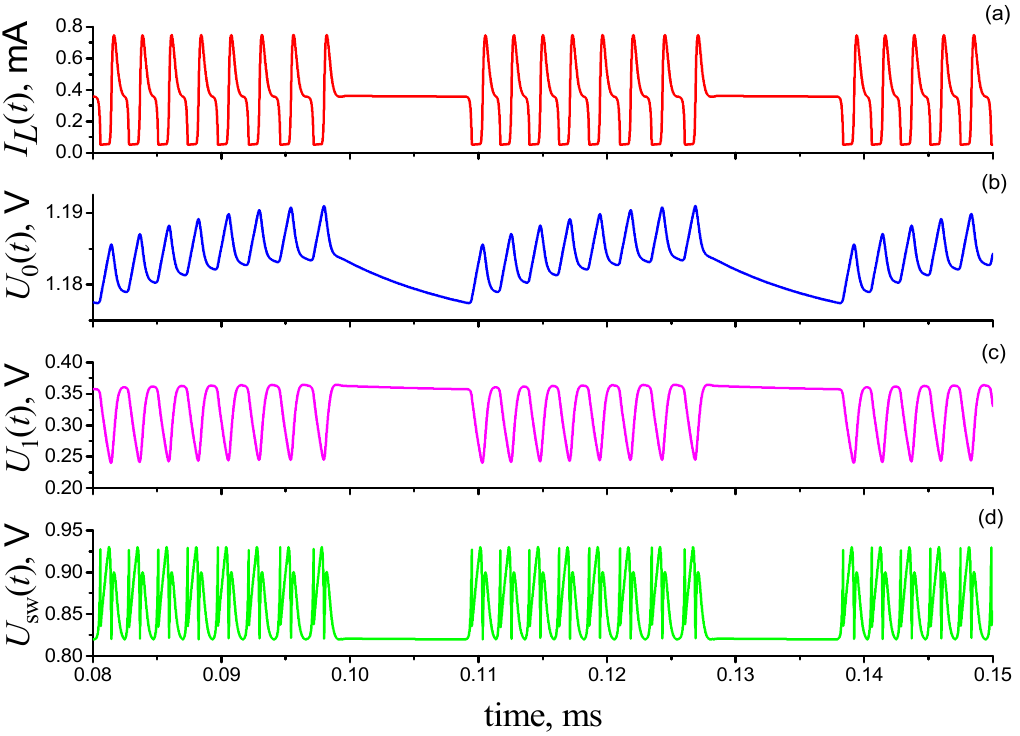
Figure 10. The time dependences of the induction current I L ( t ) ( a ), voltage U 0 ( t ) at capacitance C 0 ( b ), voltage U 1 ( t ) at capacitance C 1 ( c ), and voltage U sw ( t ) at switch ( d ) in the circuit in Figure 9a with a switching S-element (Figure 3). Electrical circuit parameters: L = 0.025 mH, C 0 =30 nF, C 1 = 1.75 nF, R 0 = 0.5 k Ω , R 1 = 1 k Ω , I 0 = 2.7 mA, I b0 =0 A, U b0 = 0 V and U in ( t ) = 0 V.